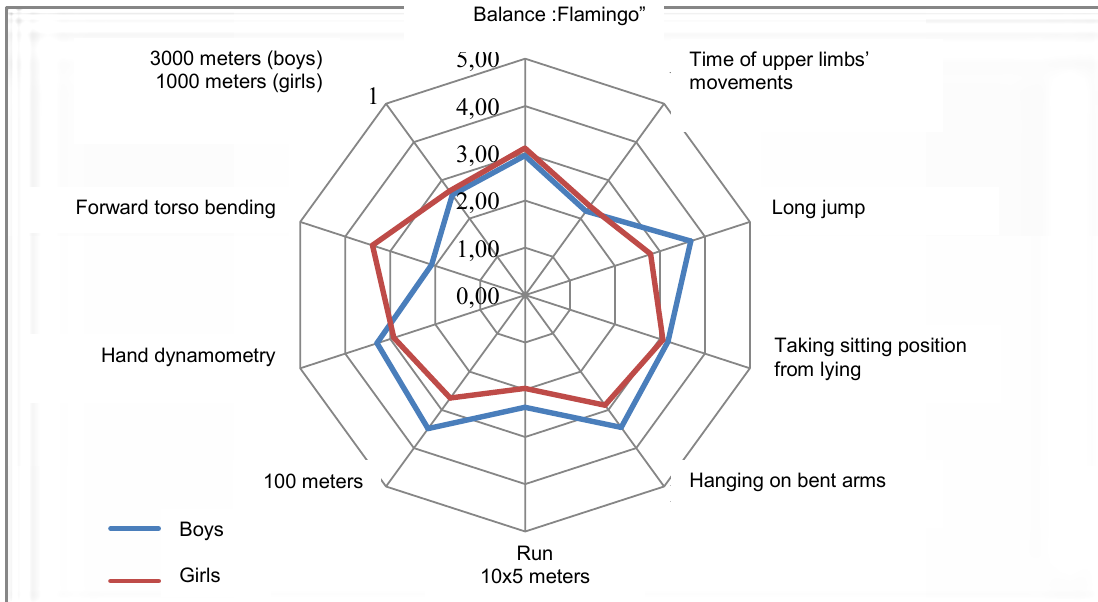
Fig.2. Mean marks in points for every motion test